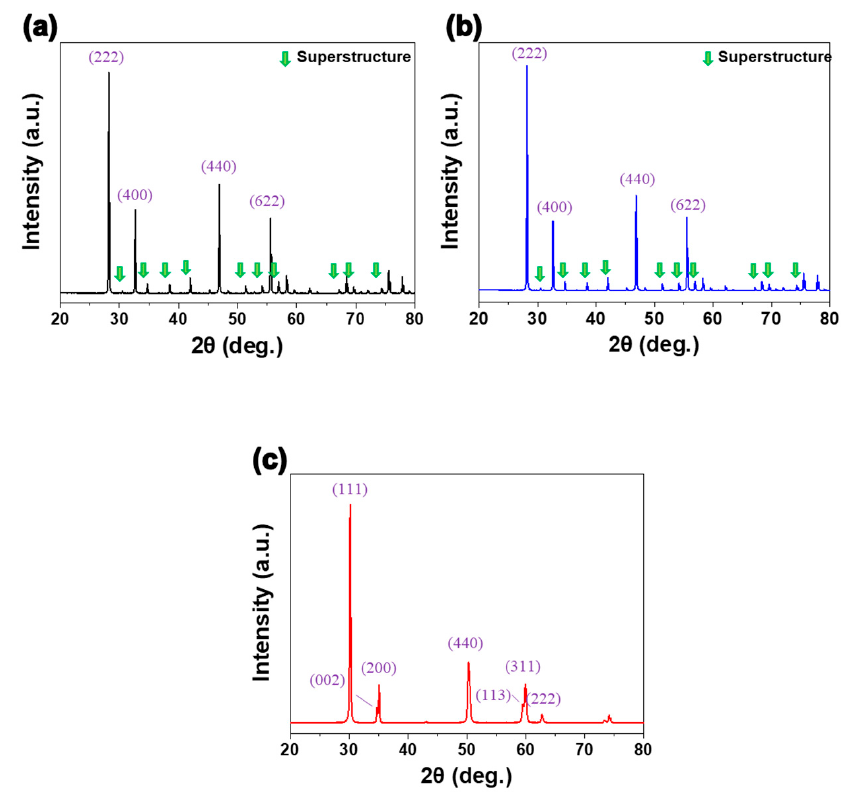
Figure 2. XRD patterns of: ( a ) REO powder; ( b ) REO coating; and ( c ) 8YSZ coating.